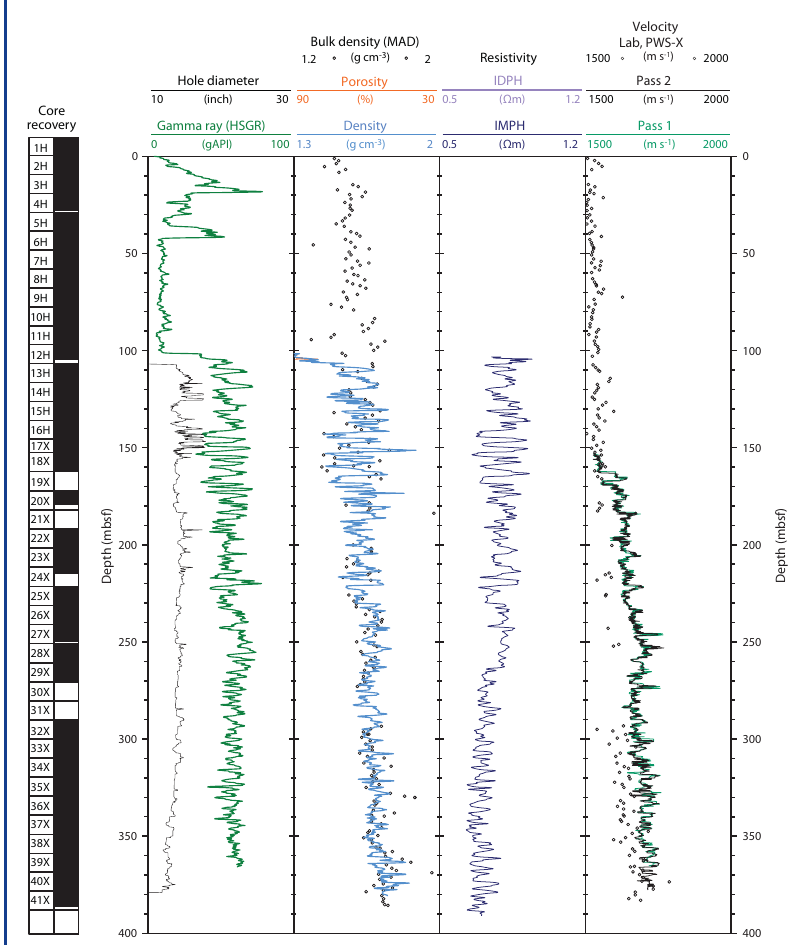
Figure 10. Downhole geophysical logs, Hole U1361A. HSGR = total spectral gamma ray, MAD = moisture and density, IDPH = deep induction phasor-processed resistivity, IMPH = medium induction phasor-processed resistivity, PWS-X = x-direction